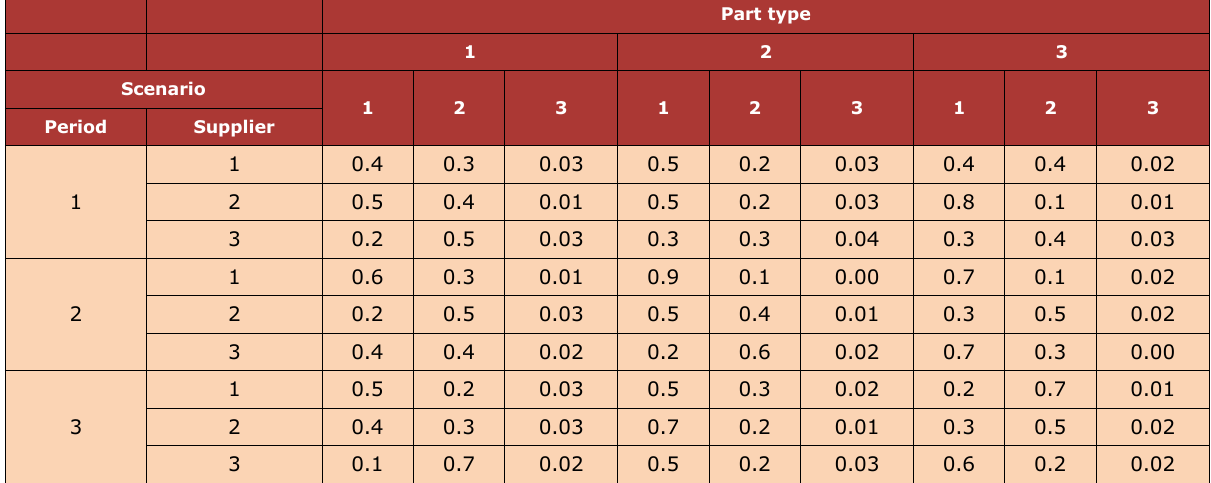
Table 2. Occurrence probability values of different